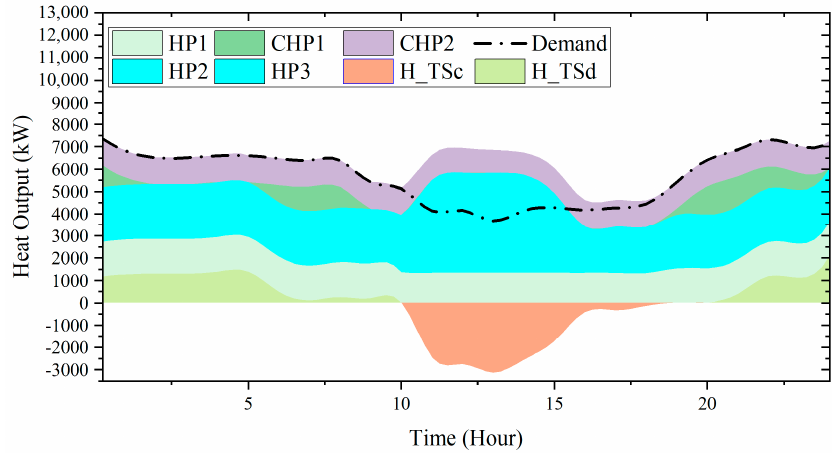
Figure 8. Heat output of local sources.